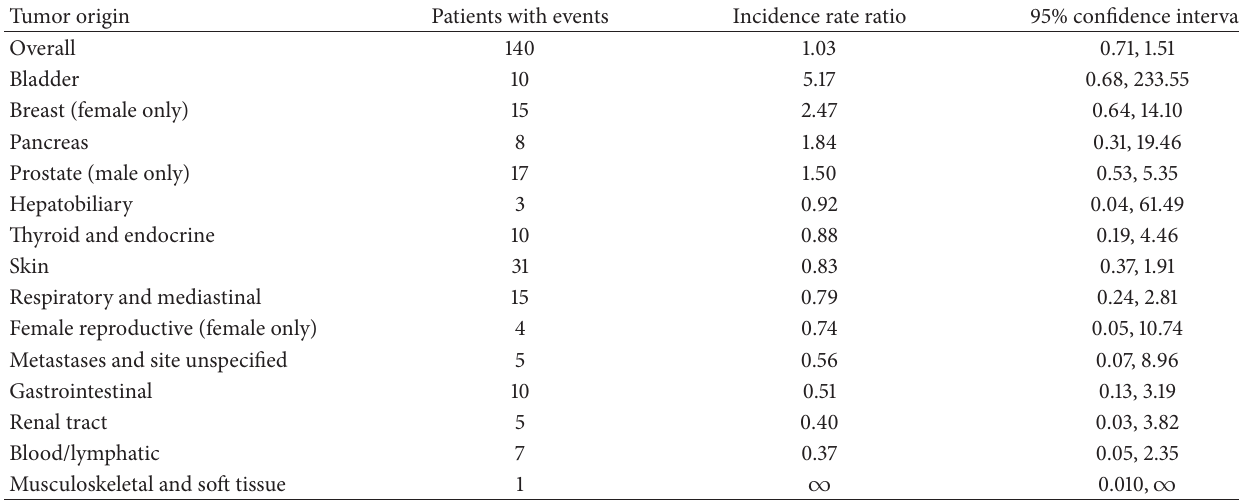
Table 2: Incidence rate ratio of malignancy by tumor type comparing dapagliflozin versus nondapagliflozin in 21 phase 2b and phase 3 clinical trials (dapagliflozin 𝑁 = 5936 and control 𝑁 = 3403